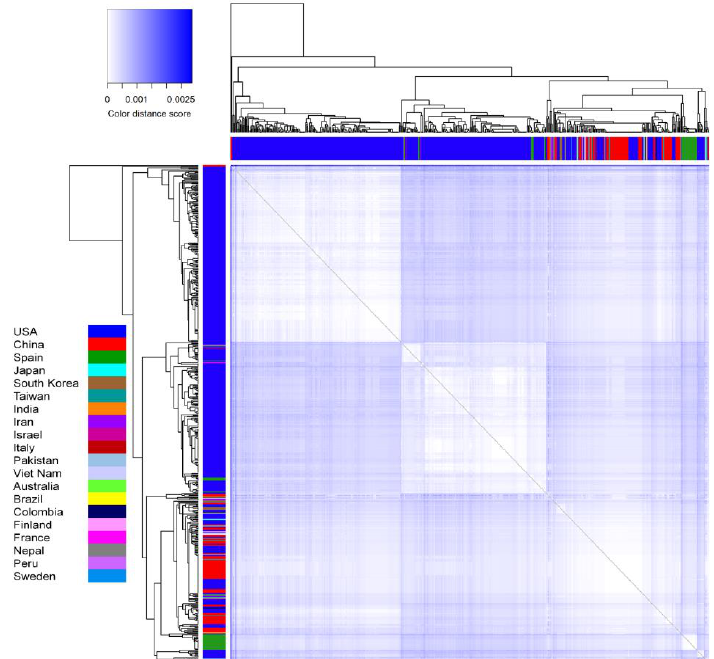
Figure 8. Heat map representing the pairwise distances among 540 genomes. The distance values among each pair of genomes are represented as color gradient. The sequences are represented as color side bars based on the country.